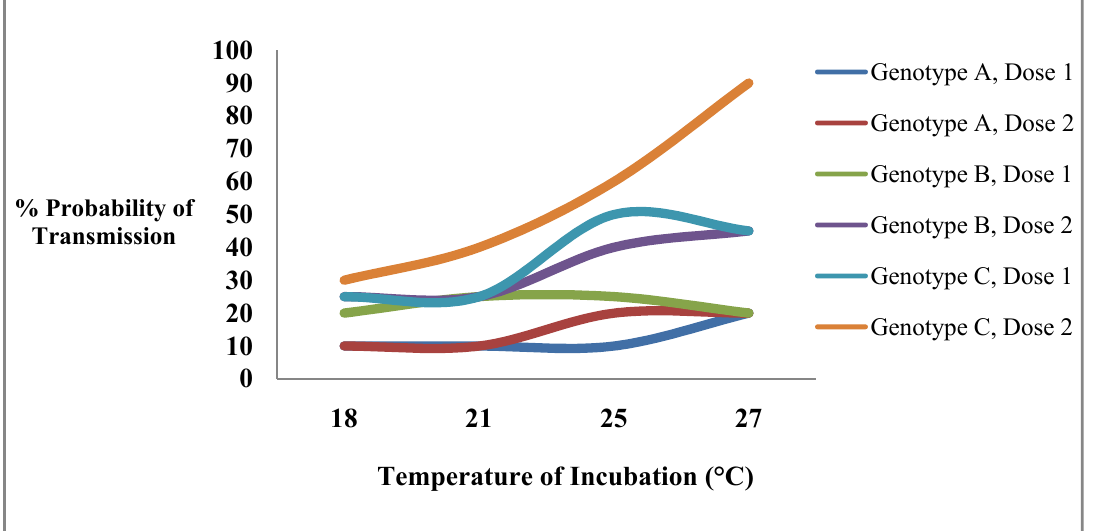
Figure 1. An example of the effects of two environmental factors (EIP, virus dose in the blood meal) and mosquito genotype on the probability of a mosquito transmitting an arbovirus. The norm of reaction of each genotype for temperature is dependent in a nonlinear way on the dose of the virus in the blood meal obtained by the